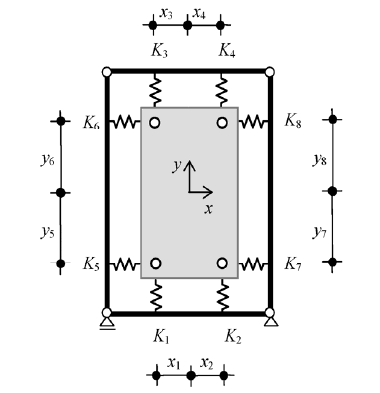
Figure 5: Notations for adhesive bonded joint.